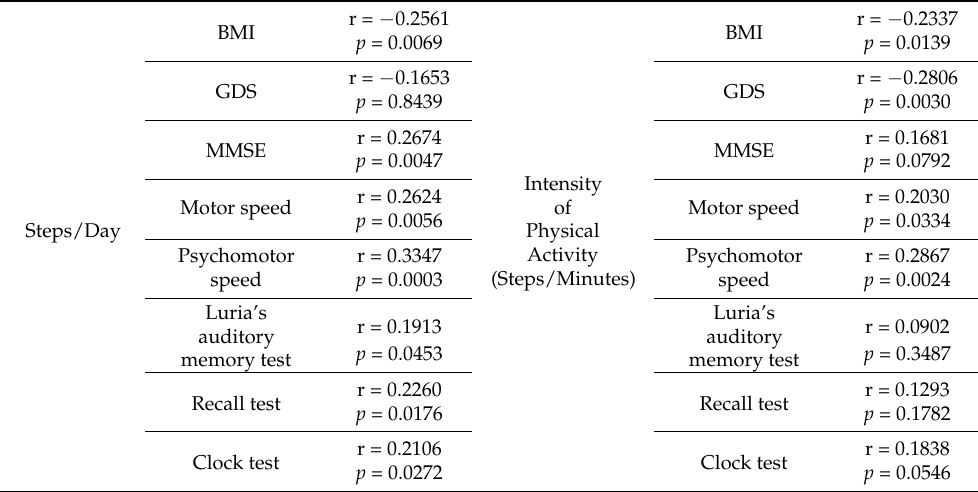
Table 4. The correlations between physical activity, expressed in the number of daily steps taken and the intensity of activity, and BMI and other assessed parameters of the health status of